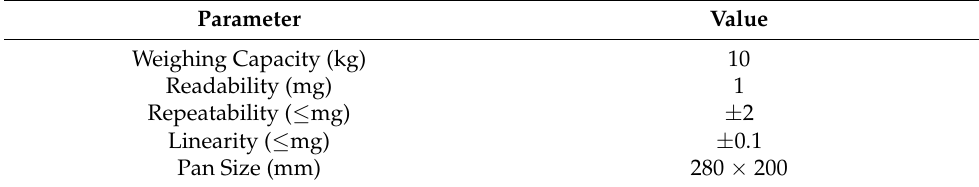
Table 3. Measurement specifications of the